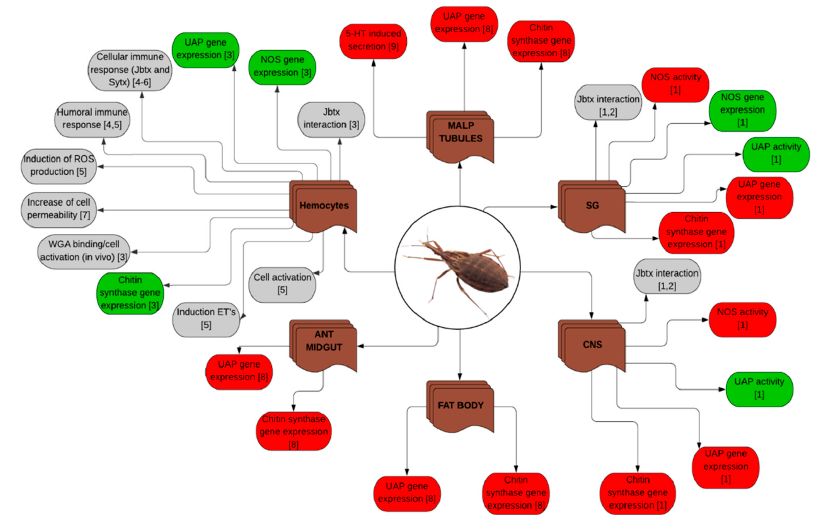
Figure 3. Tissue-specific effects of urease-derived peptides in Rhodnius prolixus . In the flowchart, the brown boxes are the organs or the cells affected by the urease-derived peptides while the grey boxes indicate no change. The green boxes represent an increase in the assessed effect while the red boxes indicate a decrease. Acronyms stand for: 5-HT, Serotonin; ANT MIDGUT, Anterior midgut; CNS,